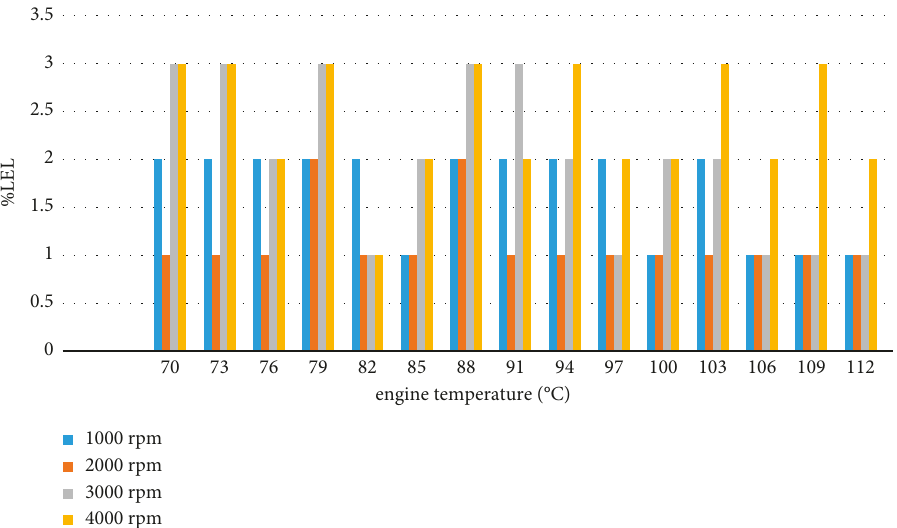
Figure 7: LEL exposure at 1m distance for different engine speeds for gasoline+H